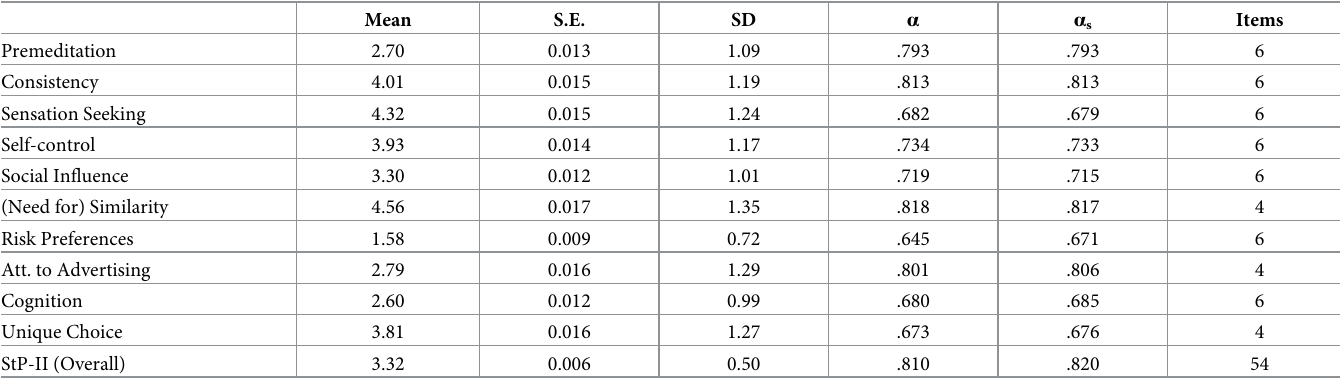
Table 5. Descriptives and reliability of susceptibility to persuasion—II scale in study 2 (n =